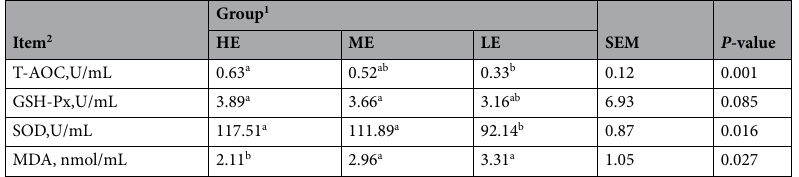
Table 5. Effects of prepartum maternal energy density on the antioxidation capability in neonatal calves. 1 HE = high energy (NEm = 1.67 Mcal/kg of DM); ME = medium energy; (NEm = 1.53 Mcal/kg of DM); LE = low energy (NEm = 1.39 Mcal/kg of DM). 2 T-AOC total antioxidant capacity, GSH-Px glutathione peroxidase, SOD superoxide dismutase, MDA malondialdehyde. a,b ,c Means bearing different superscripts in the same row difer significantly (P <